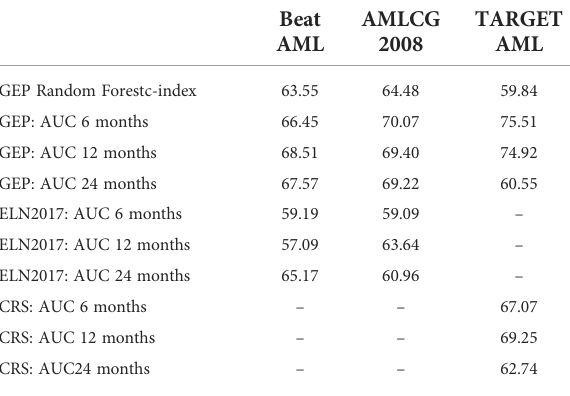
TABLE 3 Comparison in survival prediction between ELN-2017 classi fi cation and the pediatric Clinical Risk Score (CRS) with the Stellae-123 model over